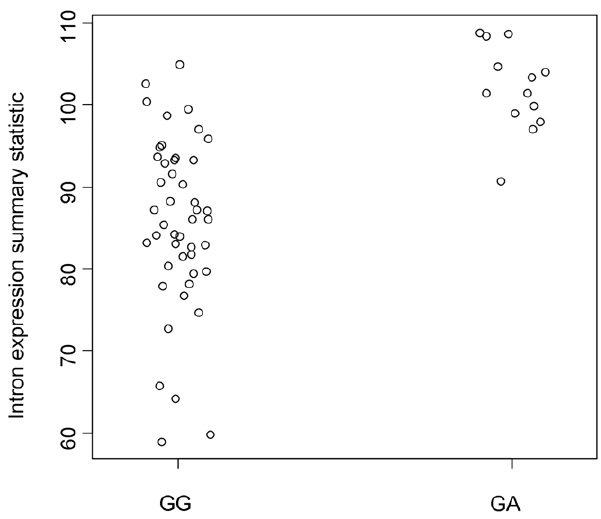
Figure 5. Stripchart of the relative intron expression pheno- type against the genotype of SNP rs9311496 in the YRI population.